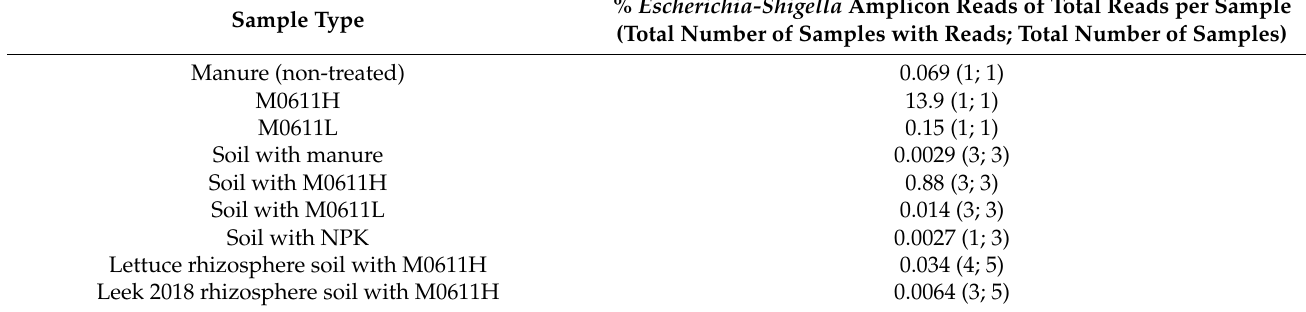
Table 2. Normalized number of Escherichia-Shigella amplicon reads in manure, soil and lettuce and leek 2018 rhizosphere soil samples.